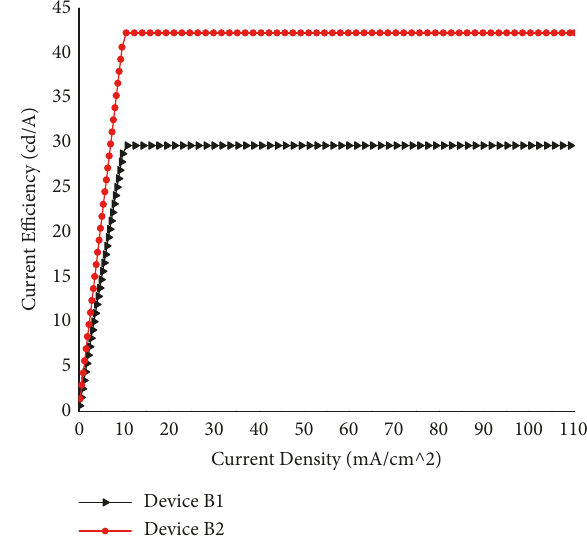
Figure 11: Absorption, PL spectra of CGL, and red emitter.